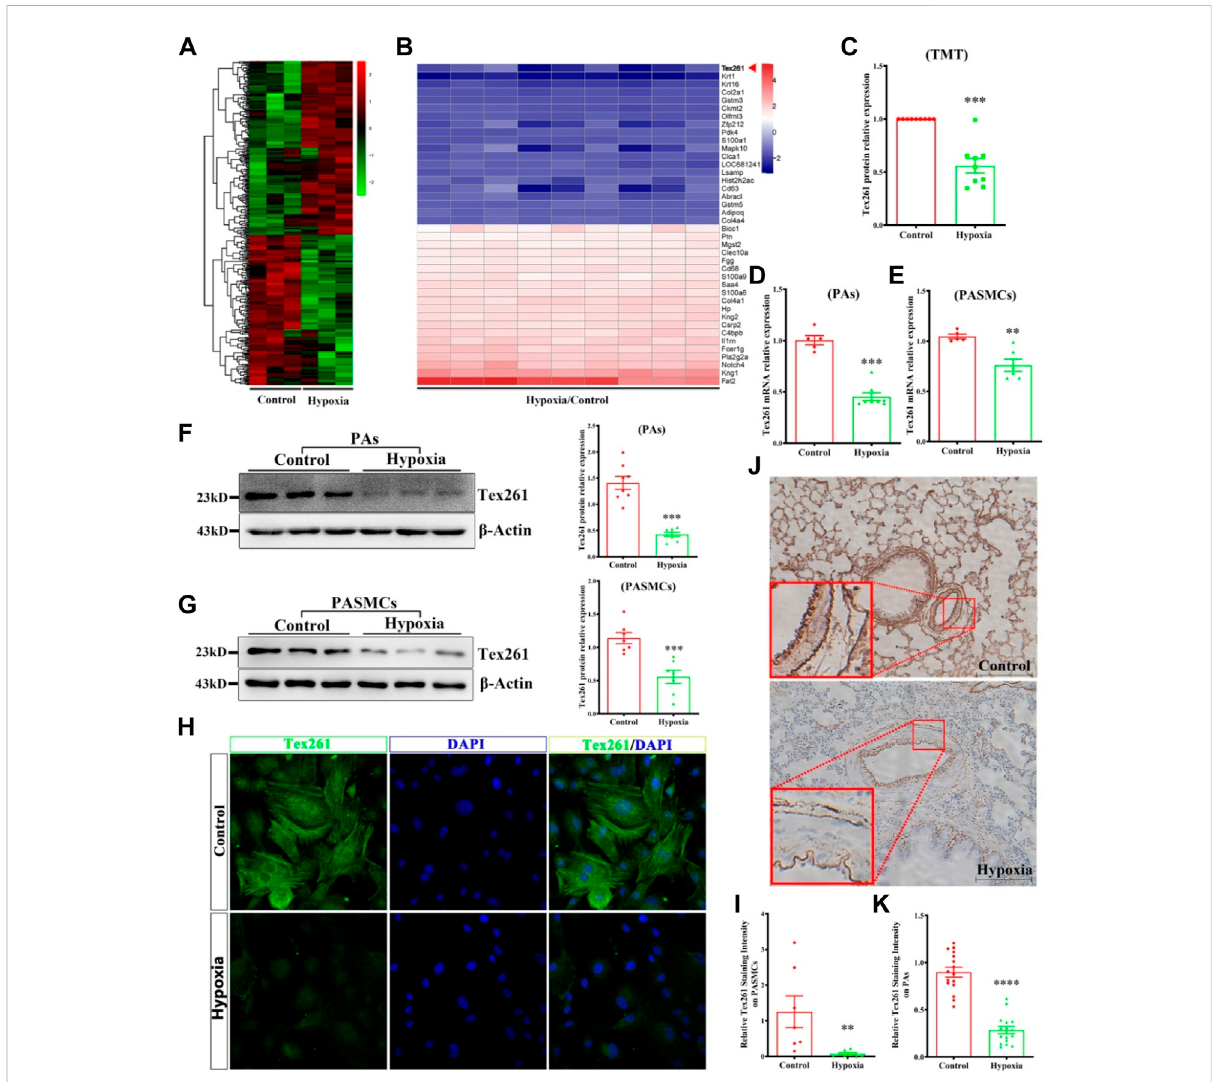
FIGURE 1 Tex261 is downregulated in hypoxic PAs and PASMCs. (A) Protein expression heatmap of hypoxia versus the control ( n = 15): unsupervised hierarchical clustering analysisof thesigni fi cantly dysregulated proteins. Red: upregulation; green: downregulation. (B) The heatmap shows the Top 20 of the signi fi cantly upregulated and downregulated proteins in the hypoxia group. (C) Tex261 protein relative expression chart in TMT data. (D,E) The mRNA levels of Tex261 in PAs and PASMCs were detected by real-time PCR ( n = 5 – 8). (F,G) The protein expression of Tex261 in PAs and PASMCs was measured by Western blotting ( n = 7 – 8). (H,I) The localization and expression of Tex261 in PASMCs were detected by immuno fl uorescence and observed under a ×20 microscope. (J,K) Tex261 mRNA was measured through ISH and observed under a ×20 microscope. The values are the mean ± SEM. * p < 0.05, ** p < 0.01 and *** p < 0.001 vs. the